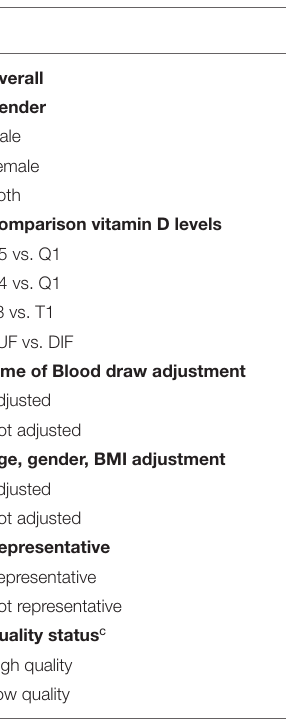
TABLE 2 | Results of subgroup-analysis for circulating vitamin D levels and risk of hypertension in Cohort